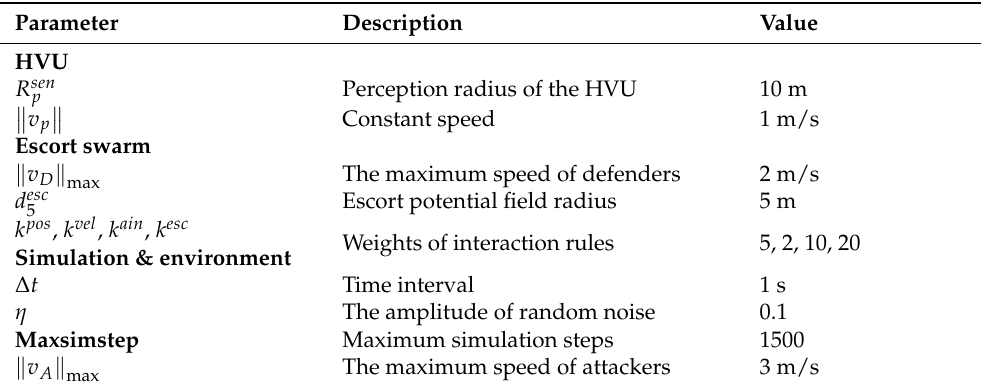
Table 3. Parameters